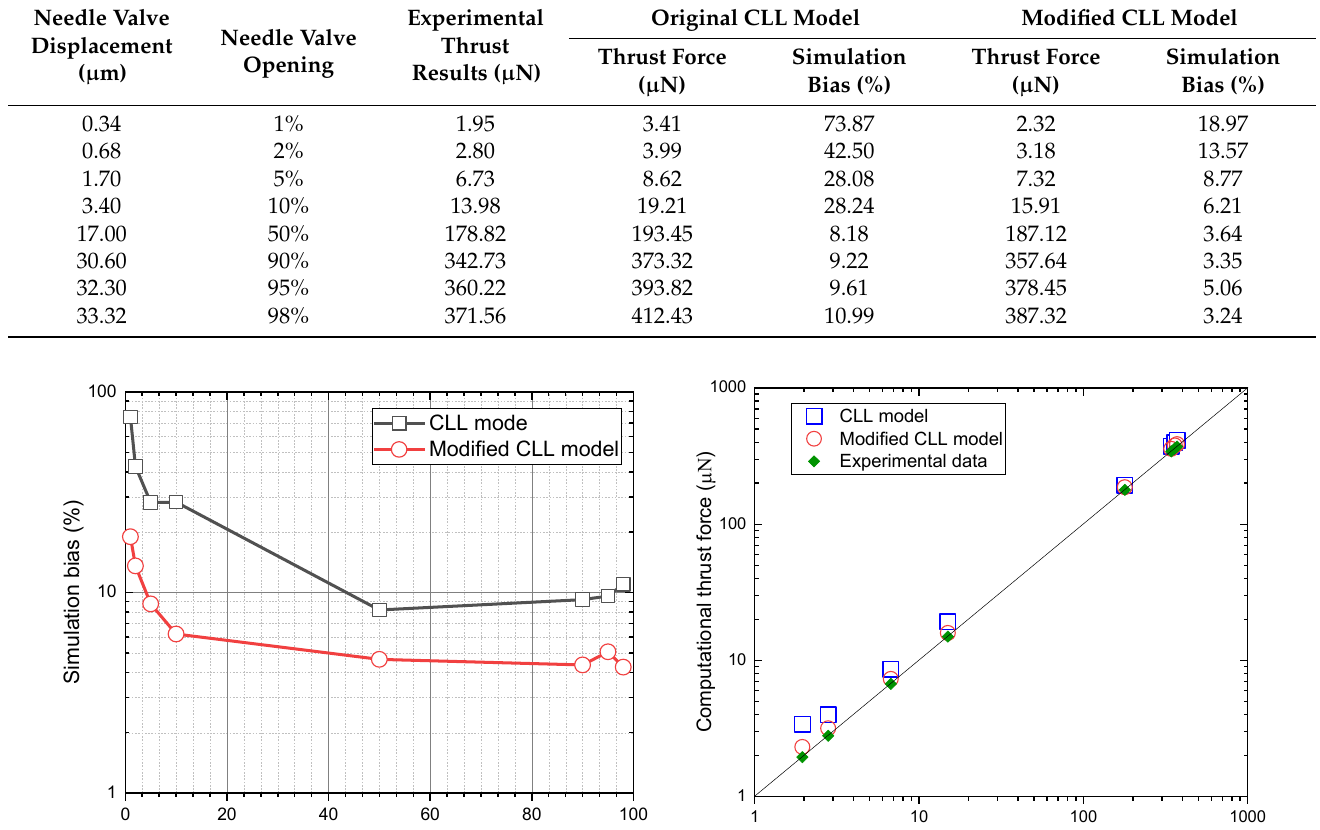
Table 2. Comparisons between experimental and computational thrust forces.